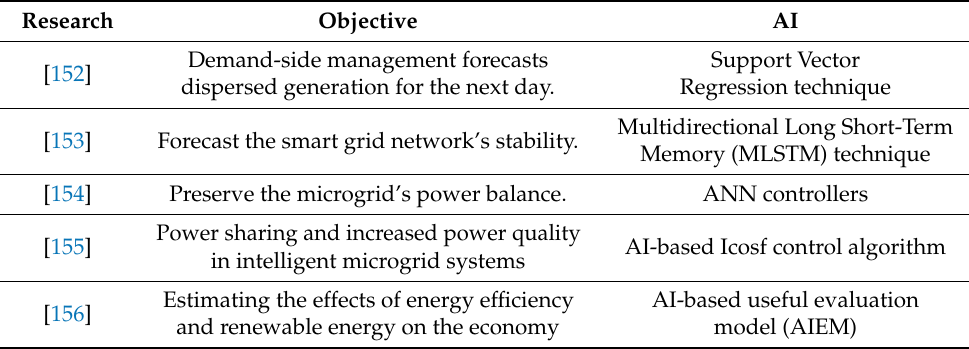
Table 4. AI in the